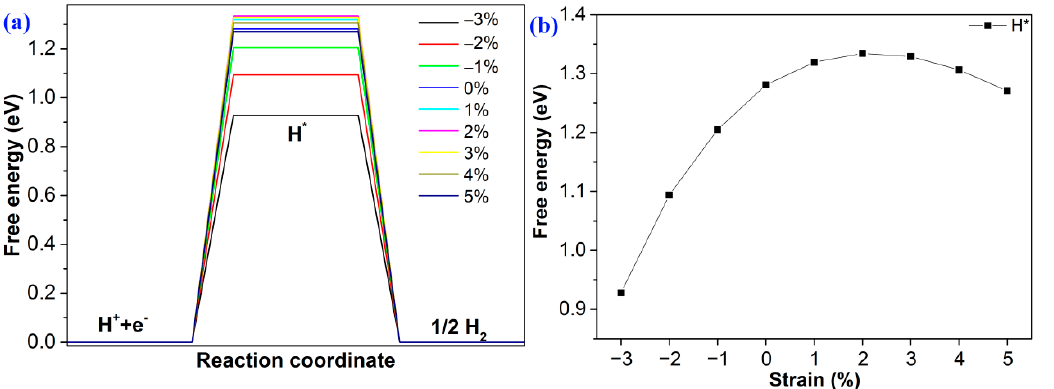
Figure 6. ( a ) The Gibbs free energy changes of HER at different strains; ( b ) the trend of ∆ G at different strains.